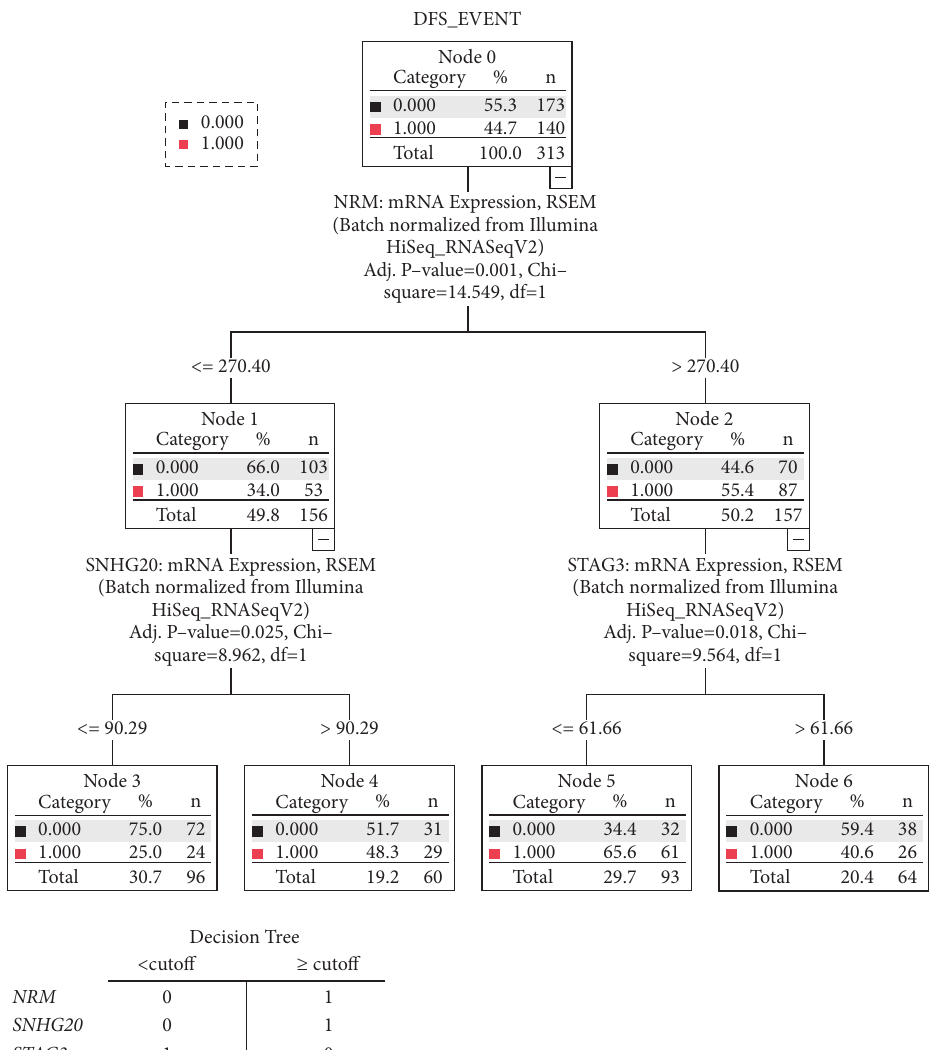
Figure 2: (a) Classification Tree Analysis was performed with the 15 most important genes derived from NNA. CTA provided three genes that were most predictable of survival along with cutoff values. (b) Based on the individual cutoff values and their predictability for survival or death, a score of either 0 (higher percentage of survival) or 1 (higher percentage of death) was